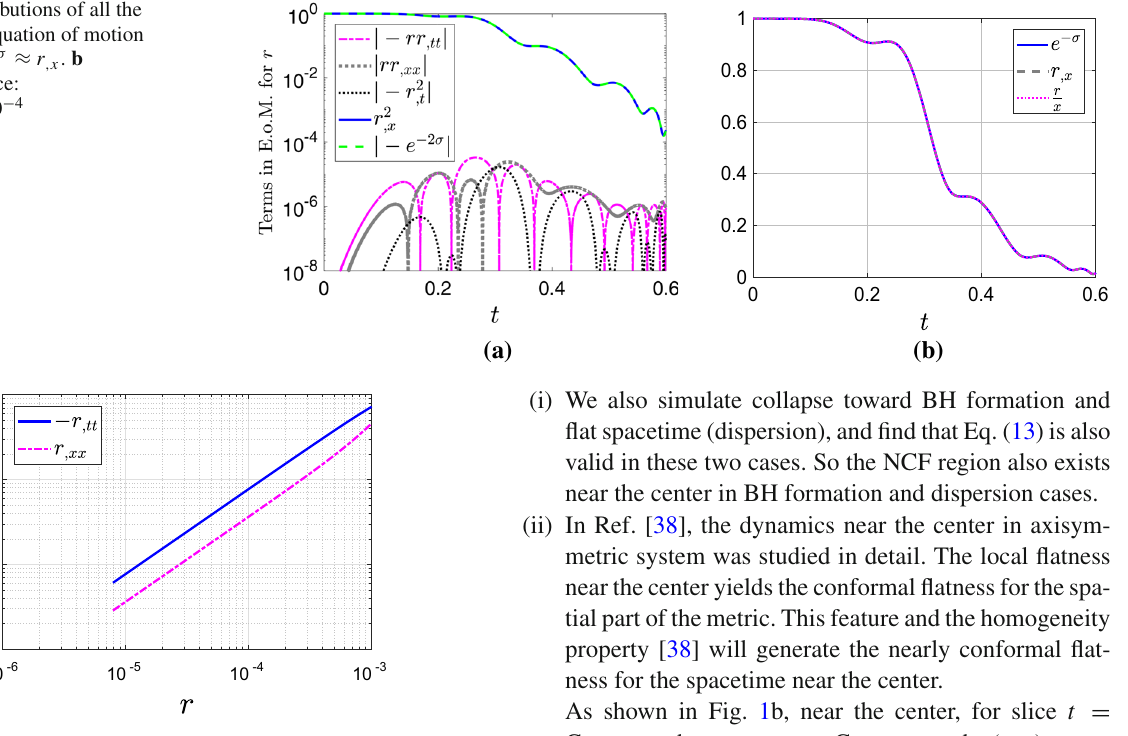
Fig. 3 ( − r tt , r xx ) vs. r near the center. Slice: t = 0 . 52